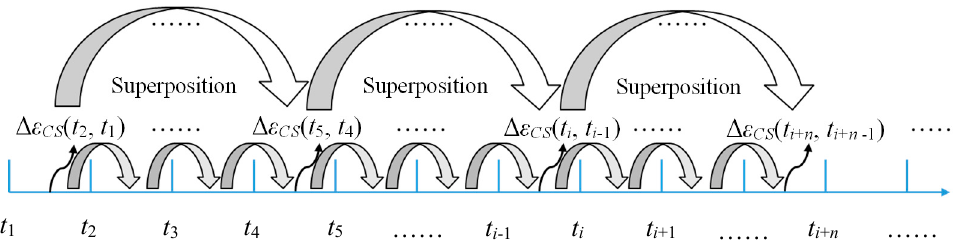
Figure 6. Schematic diagram of the stepwise analysis of concrete shrinkage and creep effect.